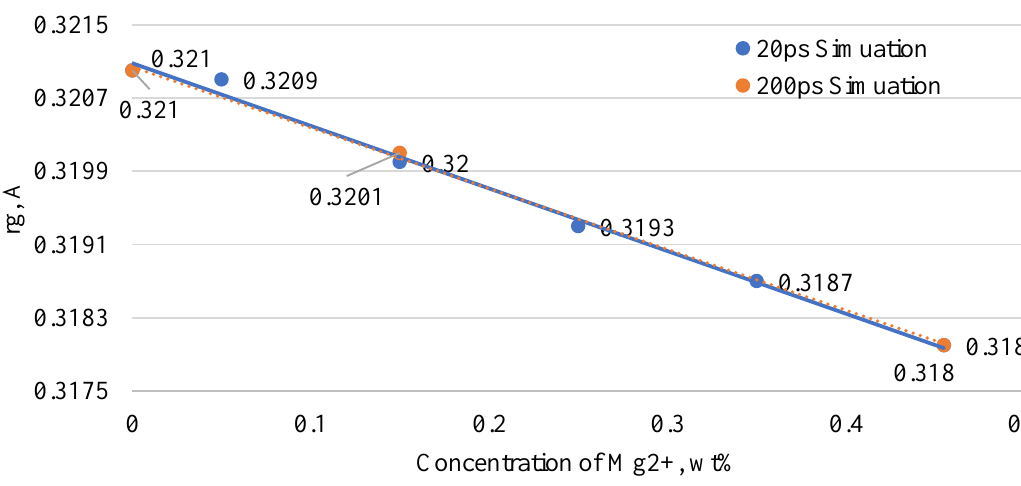
Figure 13—20ps MD simulations vs. 200ps MD simulations in magnesium chloride